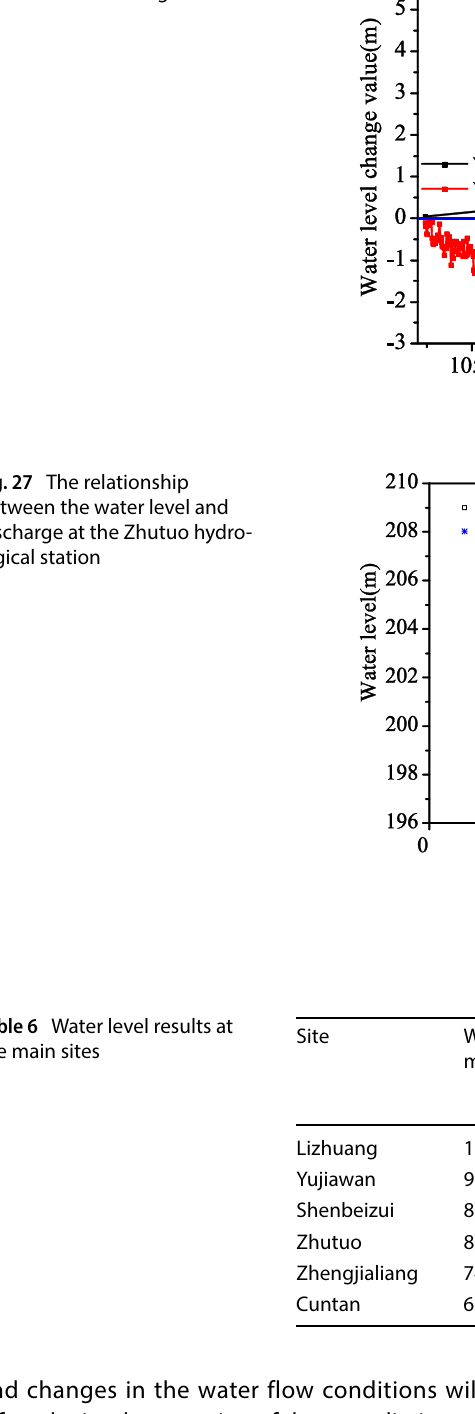
Fig. 26 Results of unsteady flow and sand mining